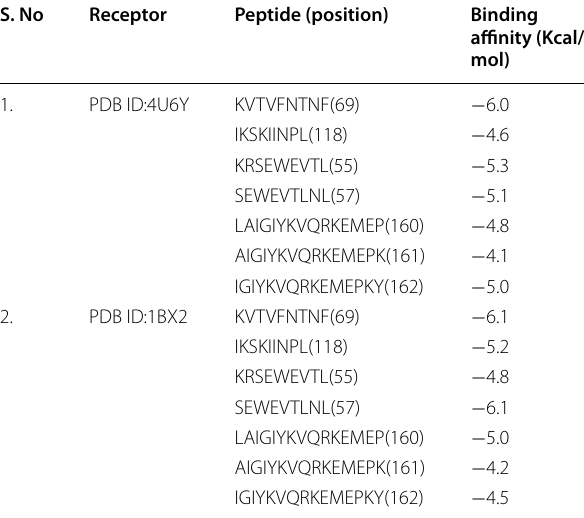
Table 5 Binding affinities of selected epitopes with HLA-A*01:01 and HLA-DRB1*